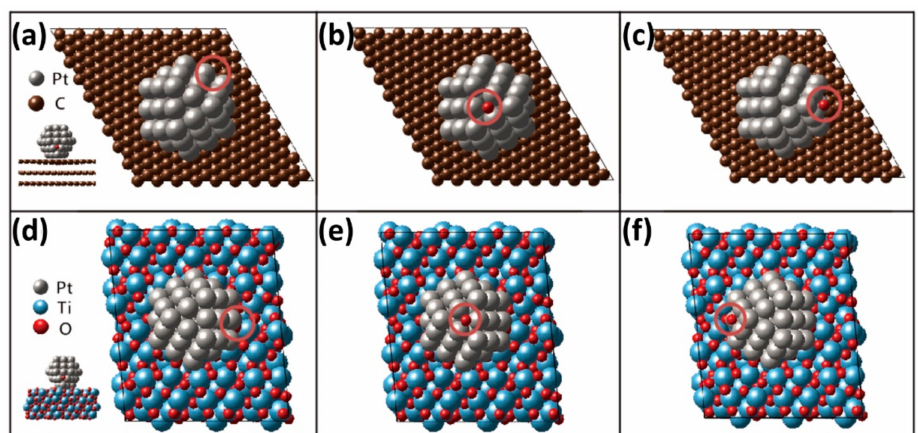
Figure 4. Top view of ( a – c ) Pt 55 /graphite and ( d – f ) Pt 55 /MPTO where O is adsorbed at top, side and bottom on the FCC sites of Pt nanoparticle, as indicated by circles.